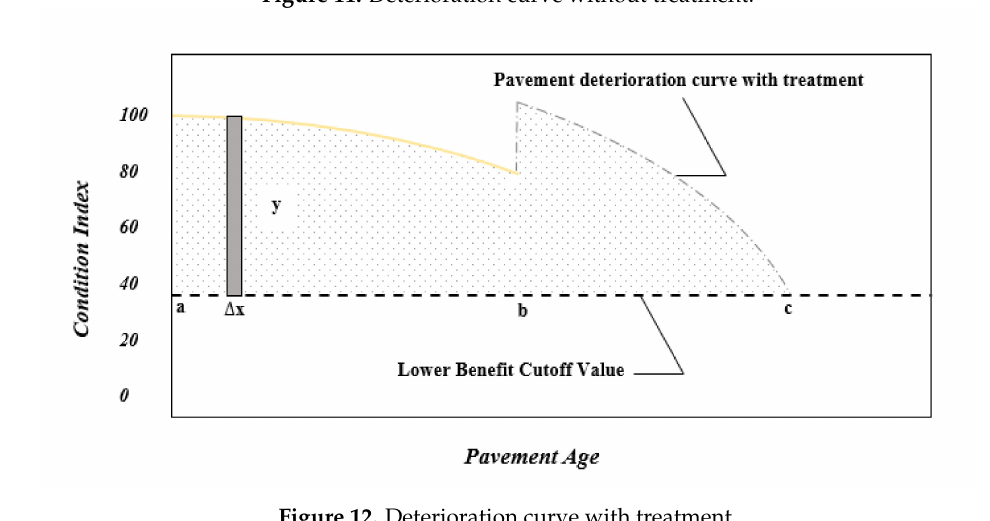
Figure 11. Deterioration curve without treatment.